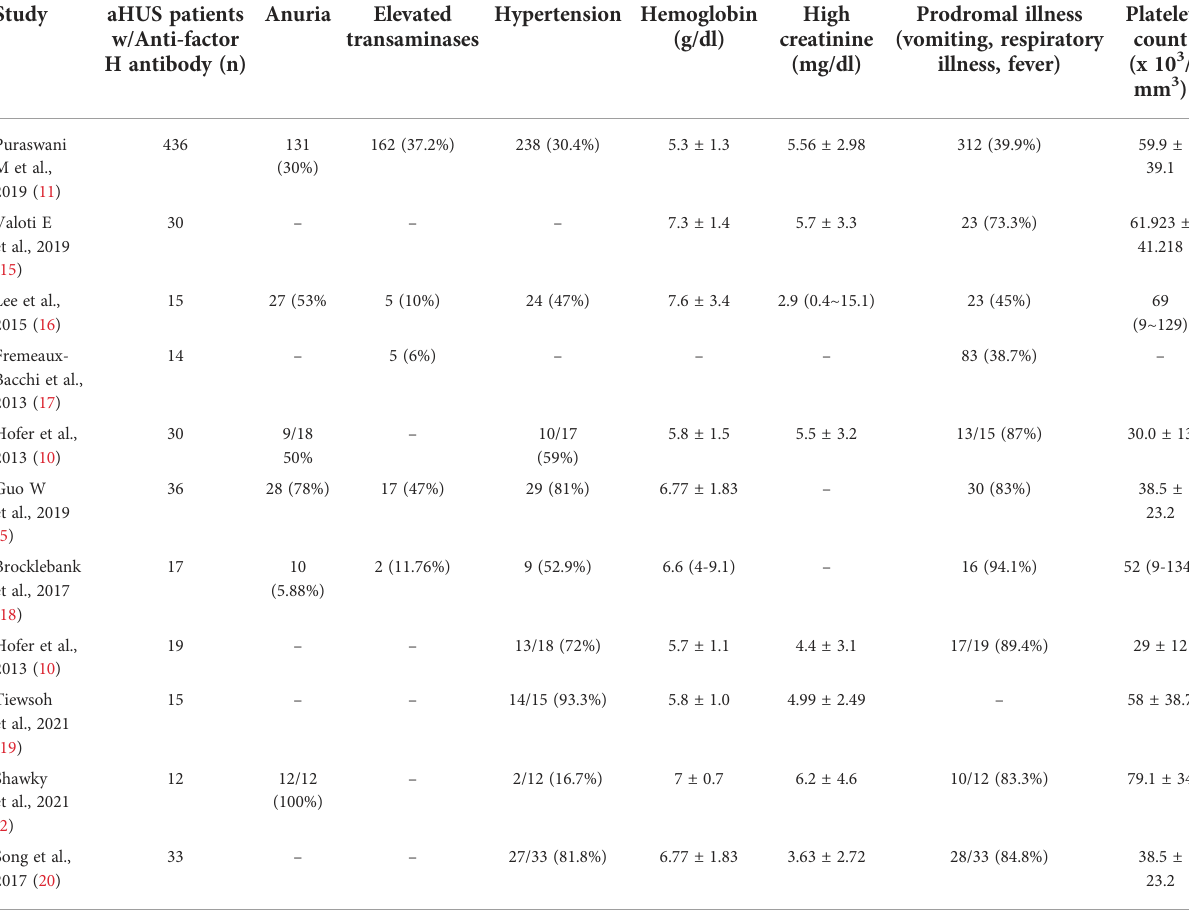
TABLE 1 aHUS patients with anti-FH antibodies across different